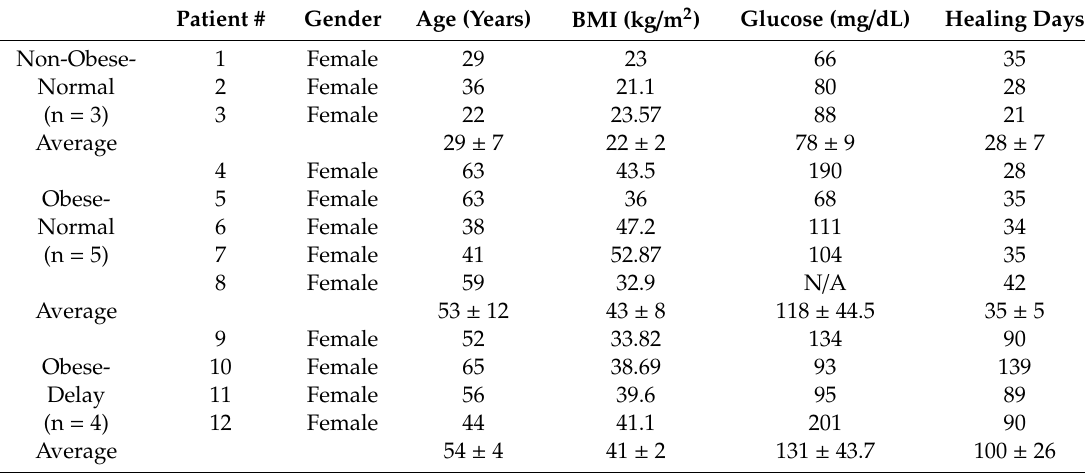
Table 1. Anthropometric characteristics of the cohort